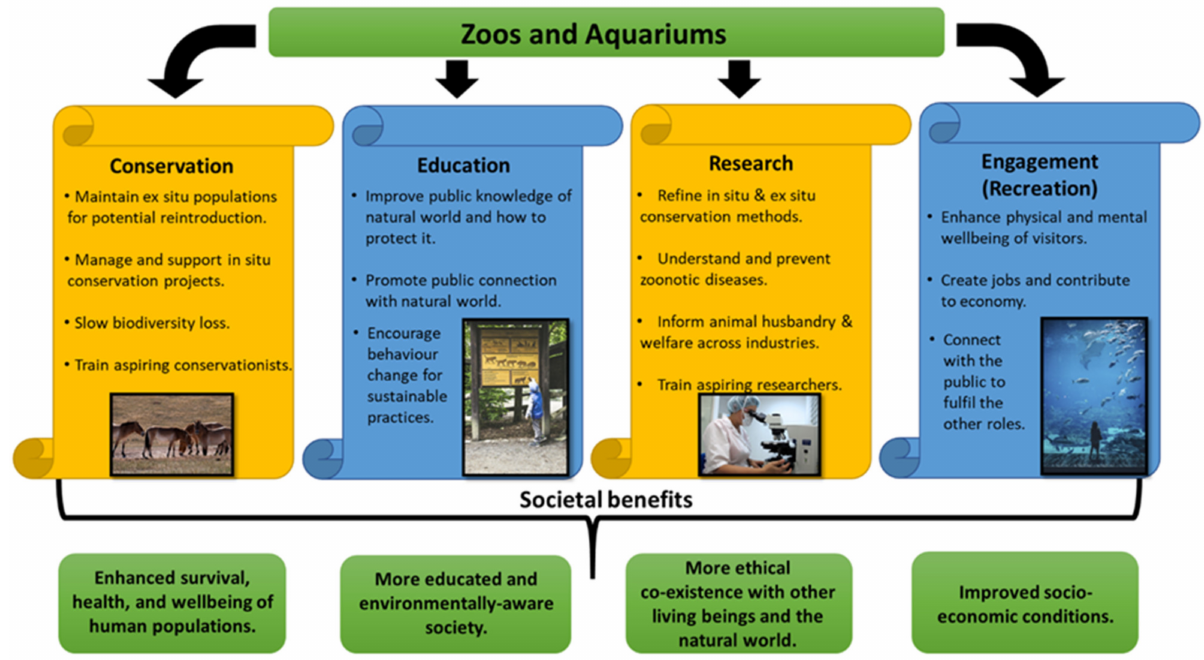
Figure 1. Wider integration of the zoo’s aims helps to expand the societal impact they have both over visitors directly and human populations further